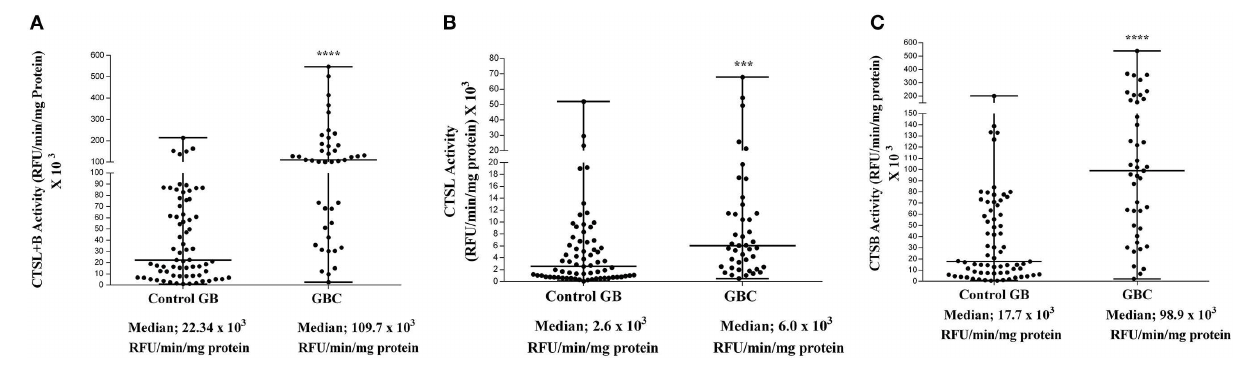
FIGURE 2 | Enzyme activity of cysteine cathepsins in GBC. Activity of each cathepsin in tissue samples of control gallbladder ( n = 69) and GBC ( n = 43) was assayed spectrofluorometrically as described in the Materials and Methods section. The activity of (A) CTSL + B, (B) CTSL, and (C) CTSB in each subject has been plotted in a dot plot. The median value in each case has been represented by a horizontal bar in the middle. Enzymatic activities of both the cathepsins were significantly higher in GBC than that of controls. All values presented as median with interquartile range (IQR). Results were analyzed using the Mann Whitney U test. *** p ≤ 0.001 and **** p ≤ 0.0001 were considered statistically